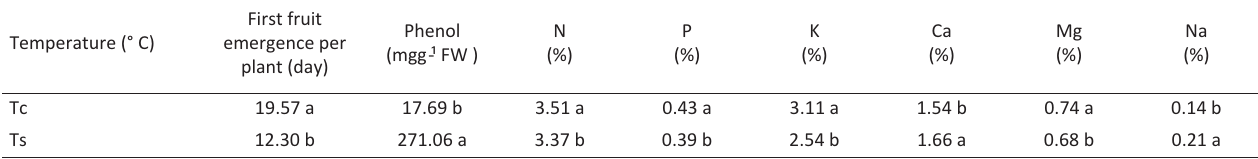
Tc= optimum temperature; Ts= low temperature. Within a column means followed by the same letter are not significantly different at P<5% according to LSD test.